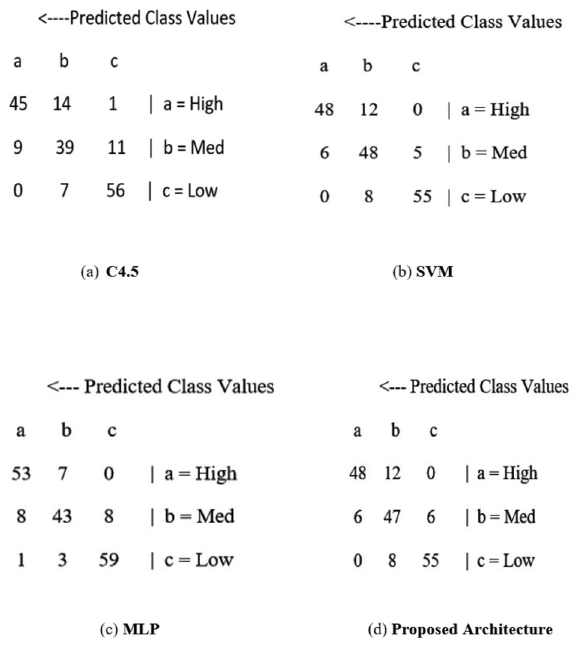
Fig. 10 Generated 3*3 confusion matrix for each classi fi er and proposed architecture after 10-Fold